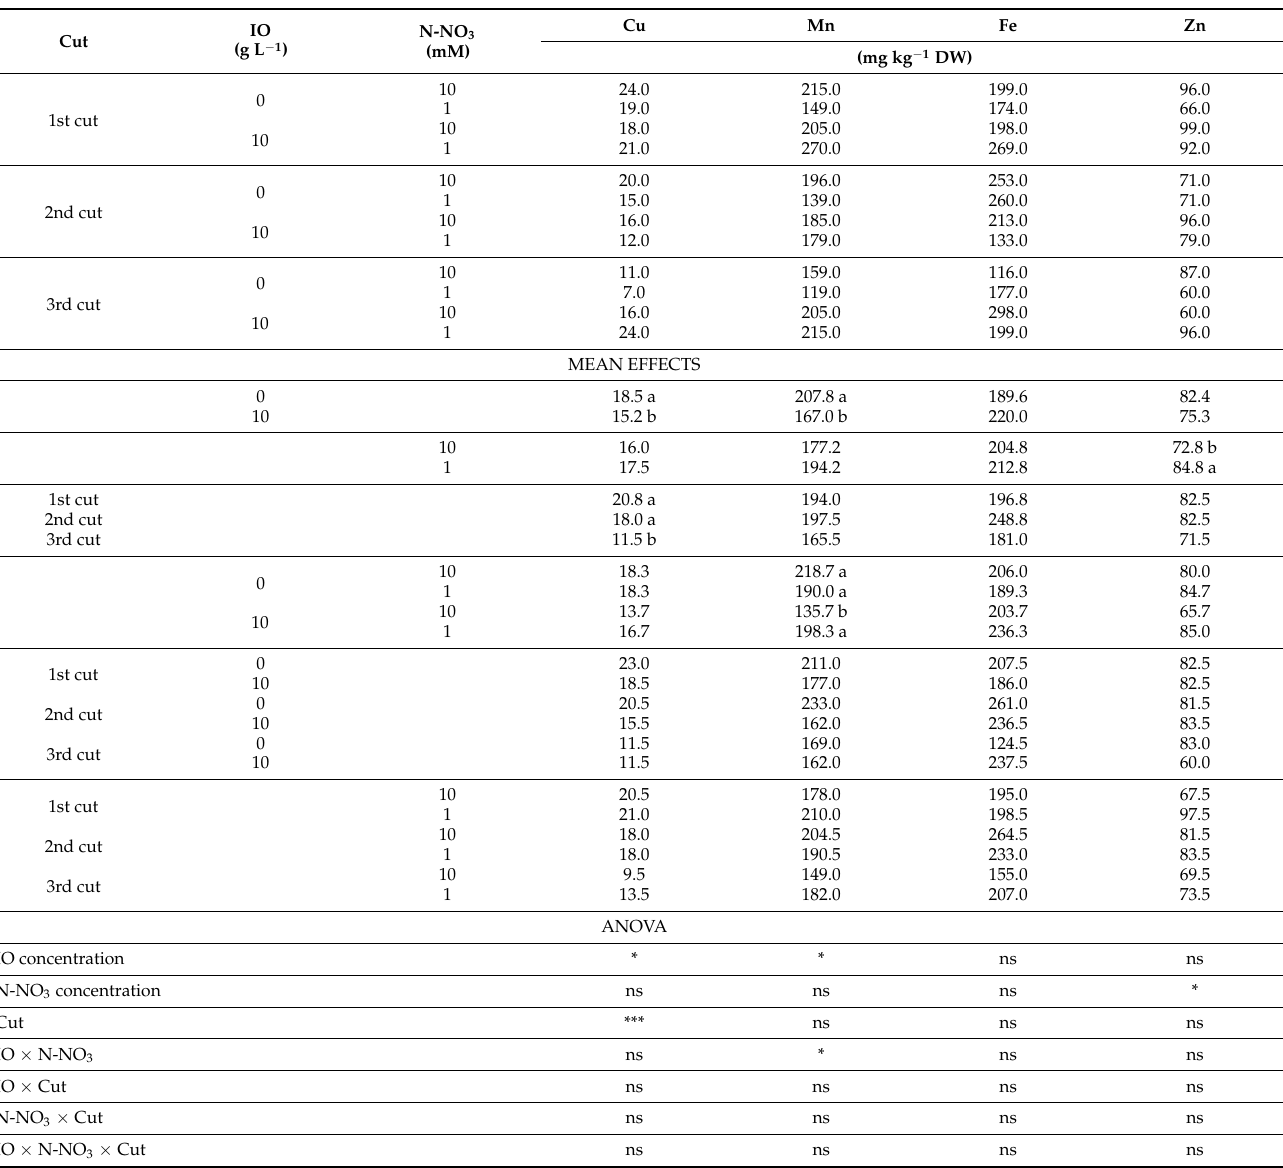
Table 10. Leaf concentration of copper (Cu), manganese (Mn), iron (Fe), and zinc (Zn) in leaves of sea beet plants grown hydroponically with different concentrations of the sea salt Instant Ocean (IO; 0 and 10 g L − 1 ) and nitrogen (1 and 10 N-NO 3 mM) in the nutrient solution. The leaves were harvested trice during the experiment (see Table 1 for more detailed information in the